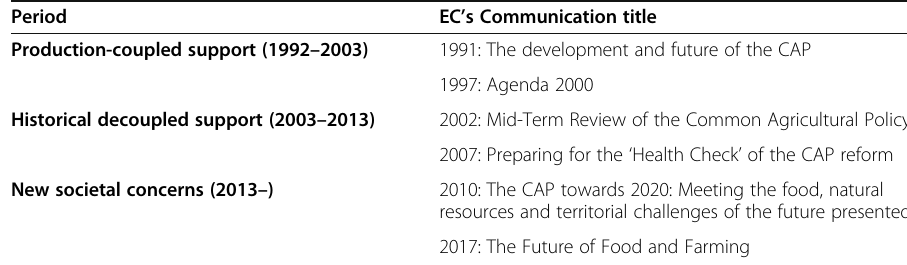
Table 1 Analysed European Commission